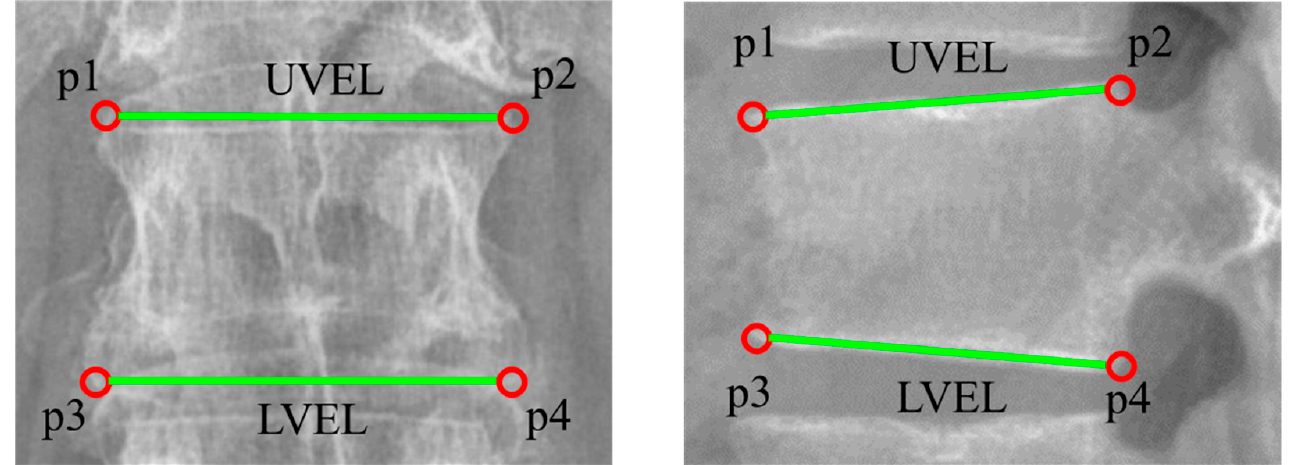
Figure 2. Definition of landmark points and upper and lower vertebral endplate lines (( Left ): AP view, ( Right ): LAT view).